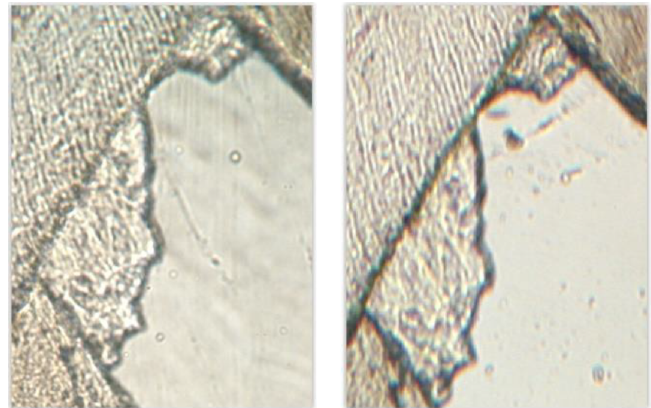
Figure 4. Equivalent fragments of the same digitalized slide in x100 magnification (left) and × 40 magnification (right) showing no significant difference